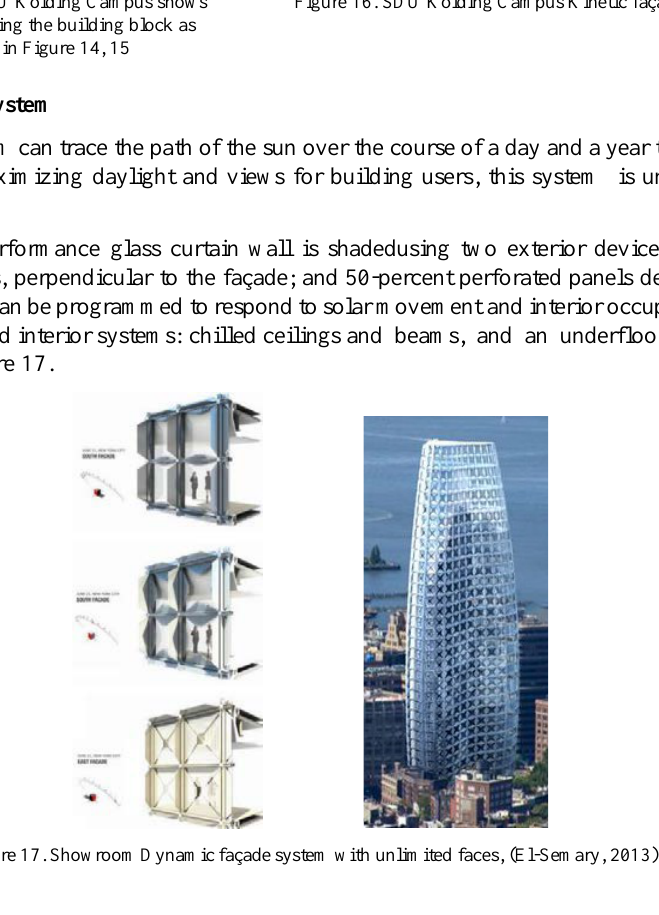
Figure 16. SDU Kolding Campus Kinetic façade detail